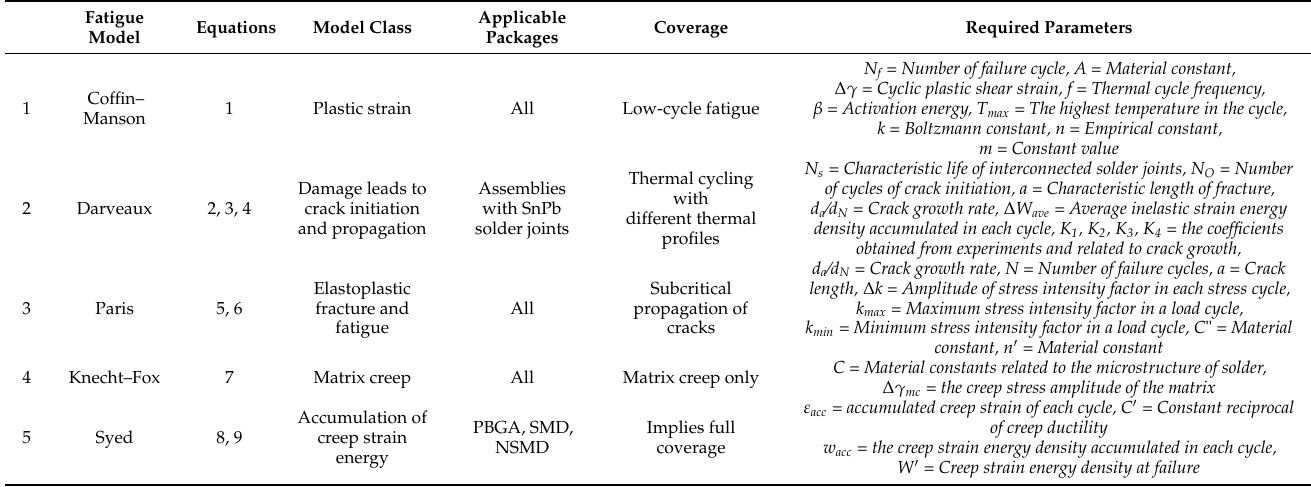
Table 6. Summary of fatigue life prediction